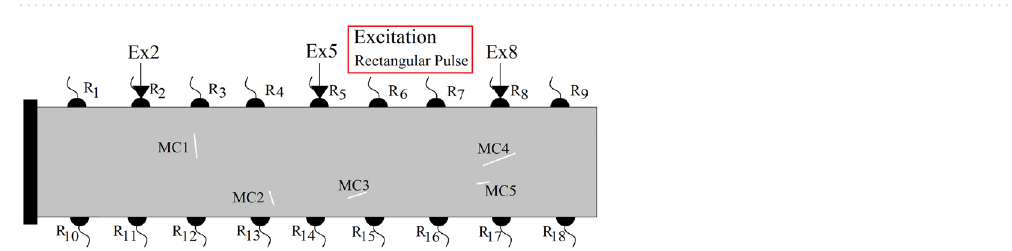
Figure 10. The generated random discontinuities and assigned excitation sources in R 2 , R 5 and R 8 .